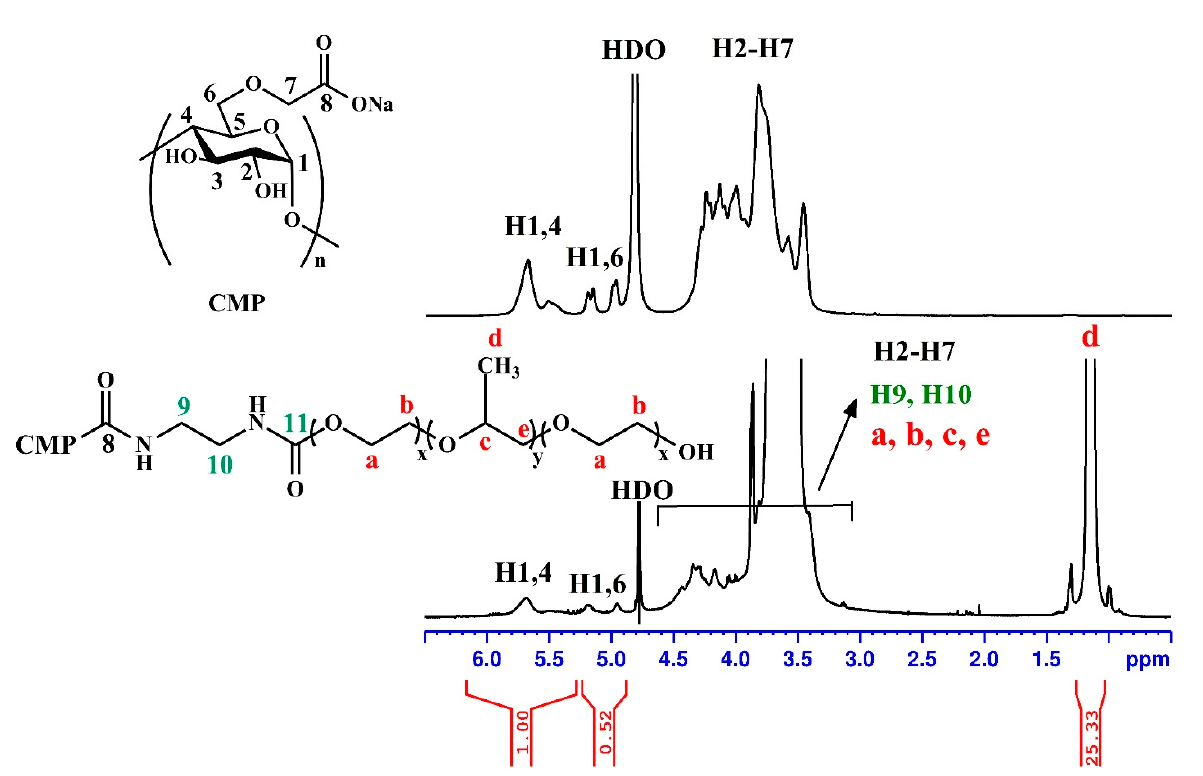
Figure 1. 1 H NMR spectra of CMP and Plx- g -CMP.